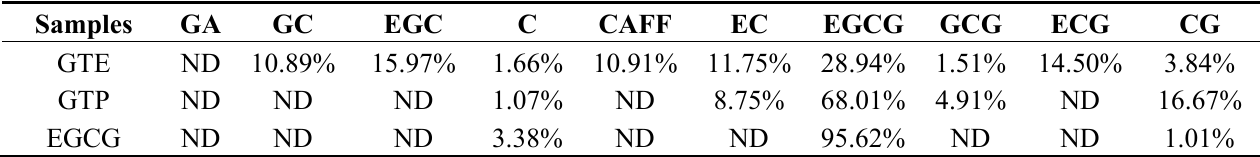
Table 3. Quantification of catechins in